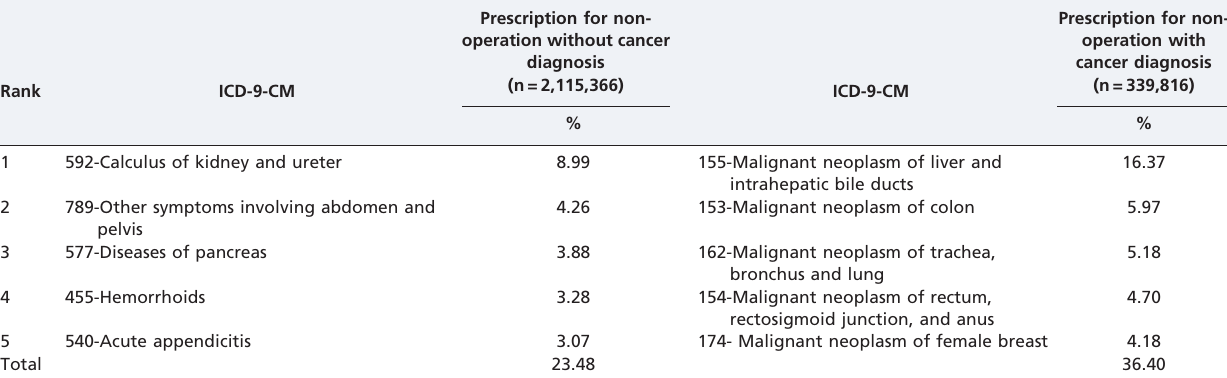
Table 5 - Leading diagnoses associated with pethidine prescriptions for non-operation patients with and without cancer diagnoses, 2002-2007.